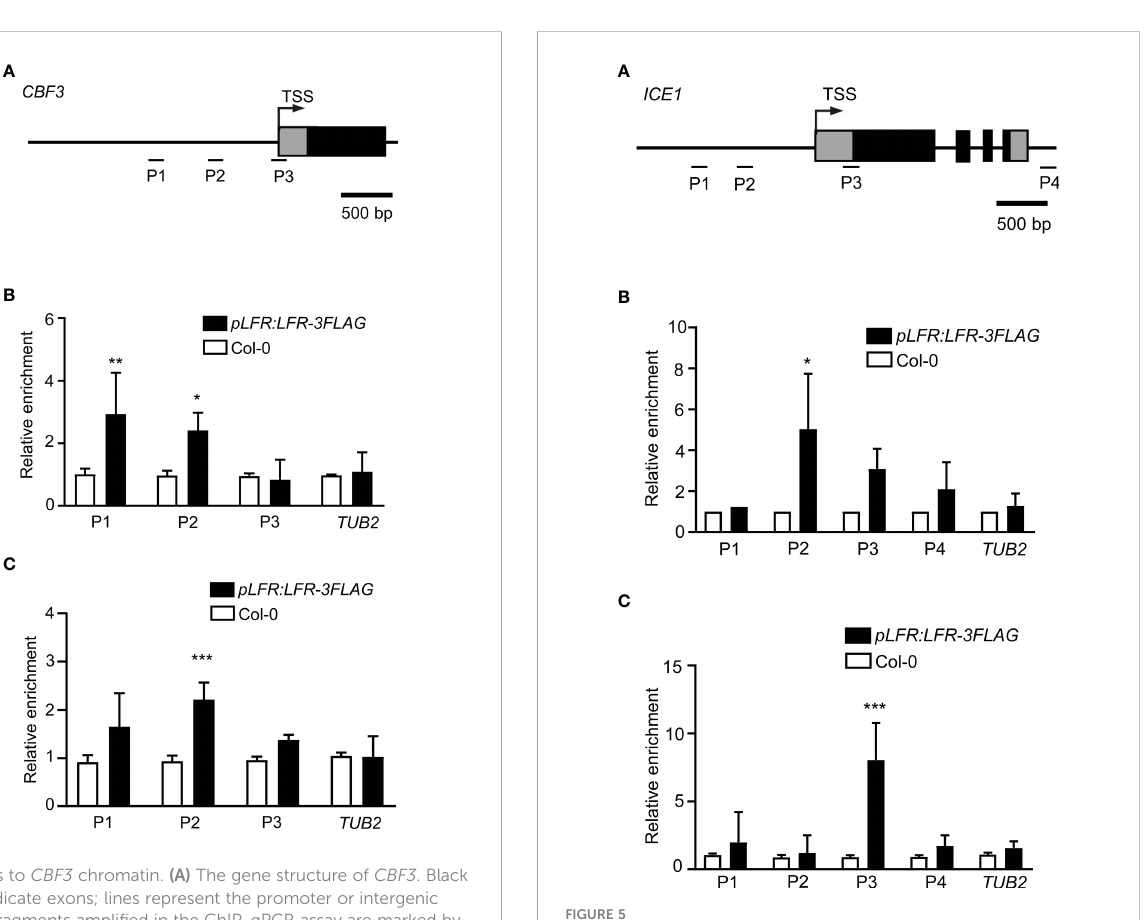
FIGURE 5 LFR binds to ICE1 chromatin. (A) The gene structure of ICE1 . Black boxes indicate exons; lines represent the promoter or introns. Fragments ampli fi ed in the ChIP-qPCR assay are marked by short lines below the gene model. TSS, transcription start site. (B, C) ChIP- qPCR assay of LFR binding to ICE1 without (B) and with 4°C treatments (C) . Error bars indicate the SD of two (4°C) or three (22° C) biological replicates. *P < 0.05, ***P < 0.001, Student ’ s t -test.